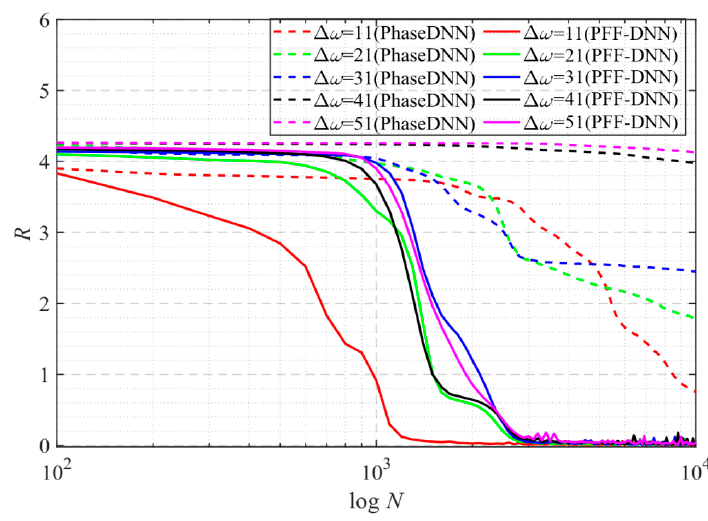
Figure 11. The influence of Δ ω on the convergence process.